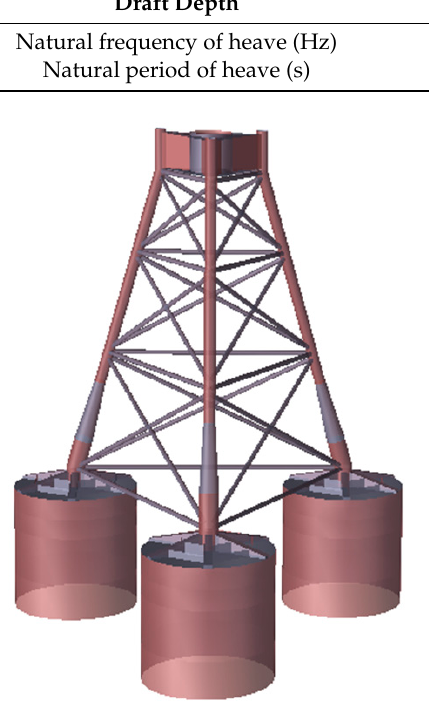
Table 5. Natural period of roll for different drafts.